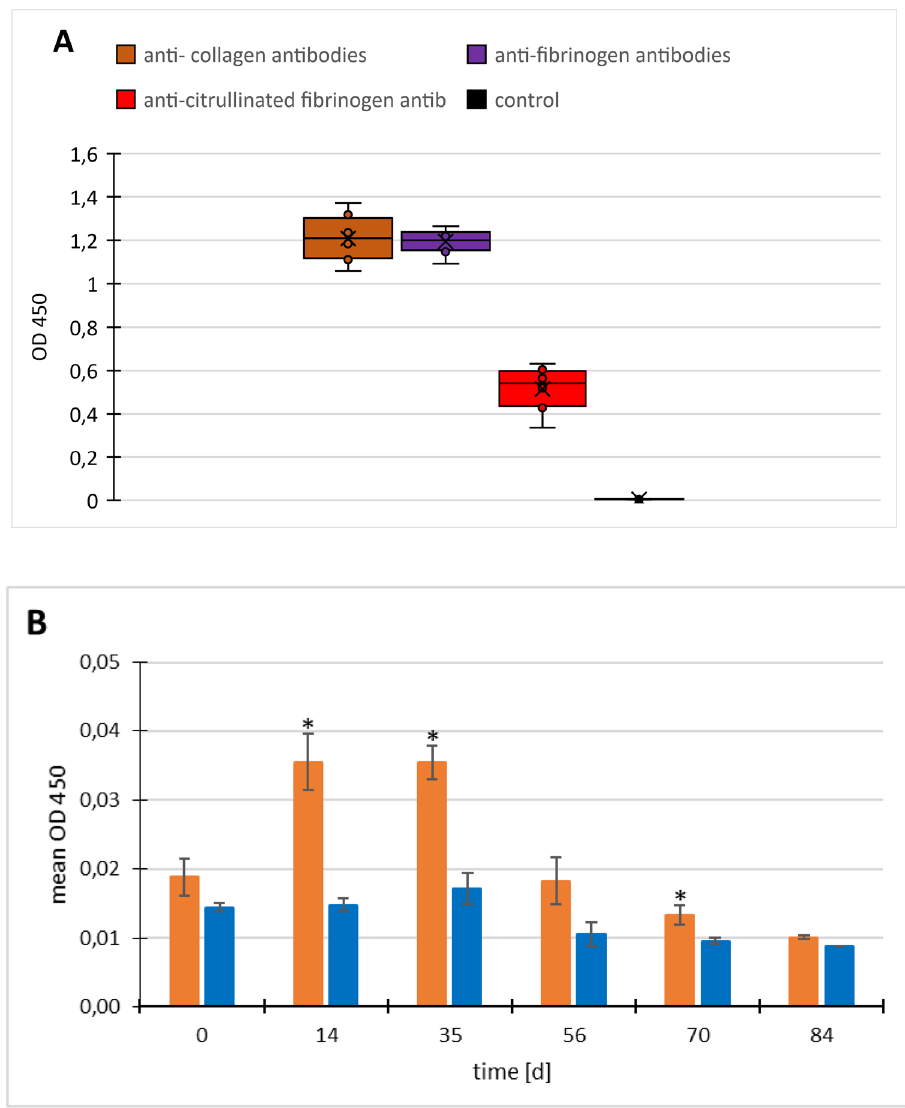
reasons of clarity we only show the values obtained at the final blood sampling upon sacrifice. Antibody titers of native control animals are shown in black, and were negative (zero values) for all 3 investigated antibodies. ( B